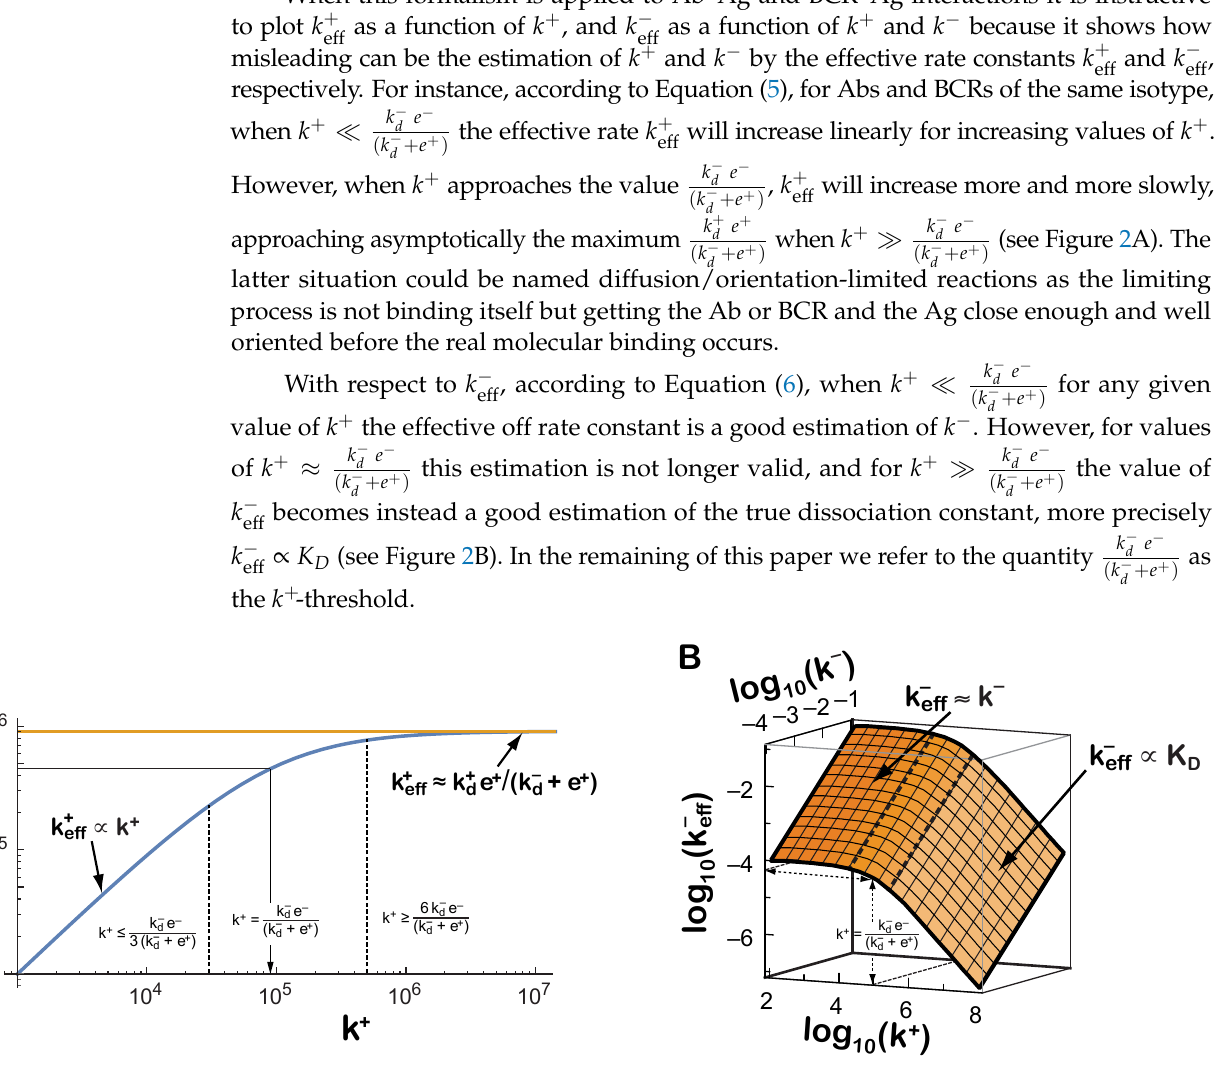
Figure 2. Effective kinetic rates measured experimentally can be misleadingly interpreted as approximations of the underlying molecular binding constant rates. Expected dependency of k + k + and k − , for a given set of values of the translational and rotational rate constants ( k + e + = 10 4 s − 1 , e − = 10 6 s − 1